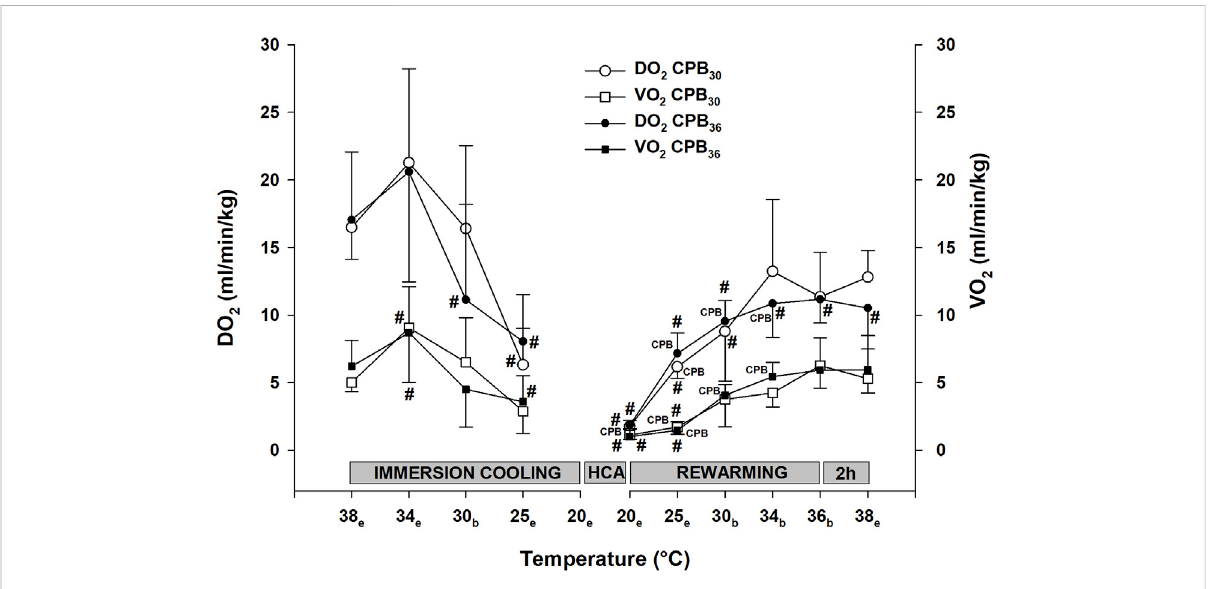
FIGURE 4 Oxygentransport.DO 2 – Globaloxygendelivery,VO 2 – oxygenuptake.Temperaturemeasuredin:e – esophagus;b – bladder.Datapresented as mean and SD. # p < 0.05 vs. intragroup baseline; CPB – variables measured during ongoing